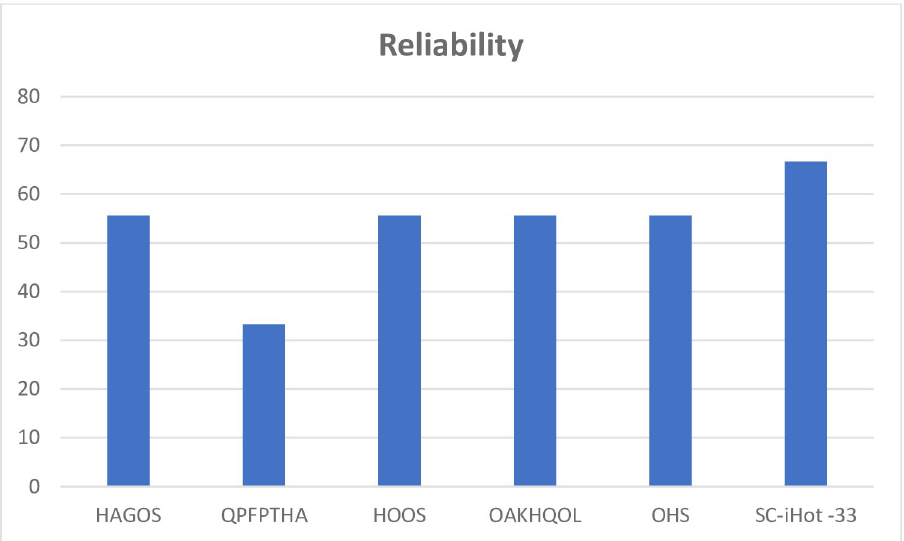
Fig 3. Cultural and language adaptation attribute score for each PROM as evaluated by